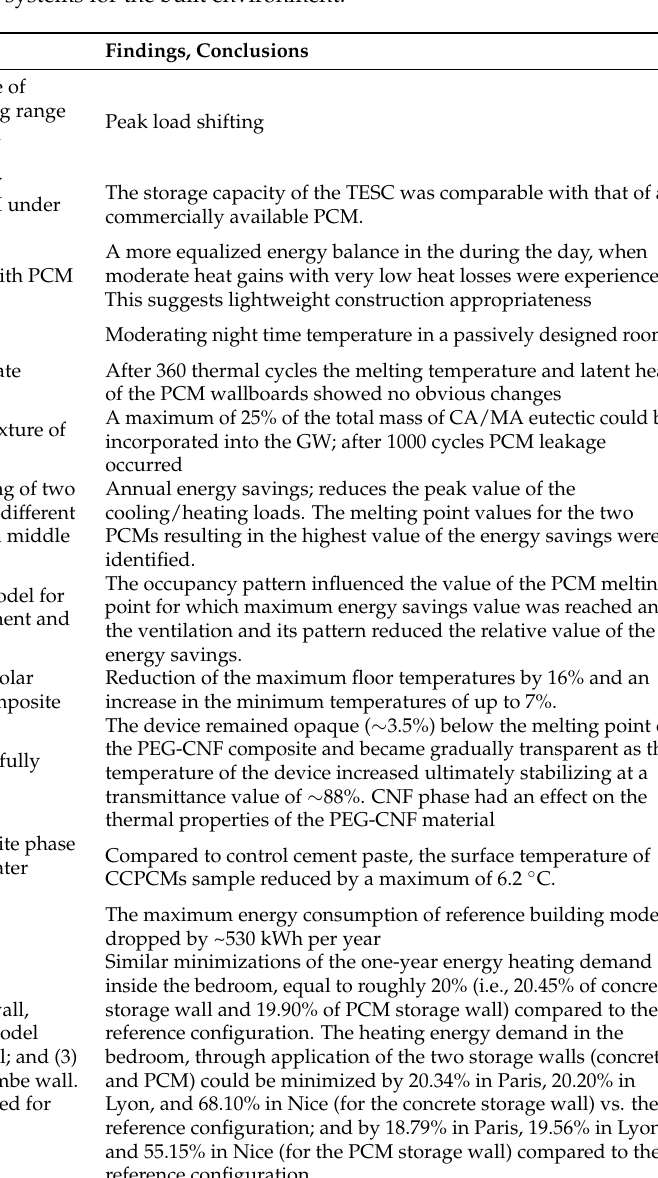
Table 1. Passive PCM storage systems for the built